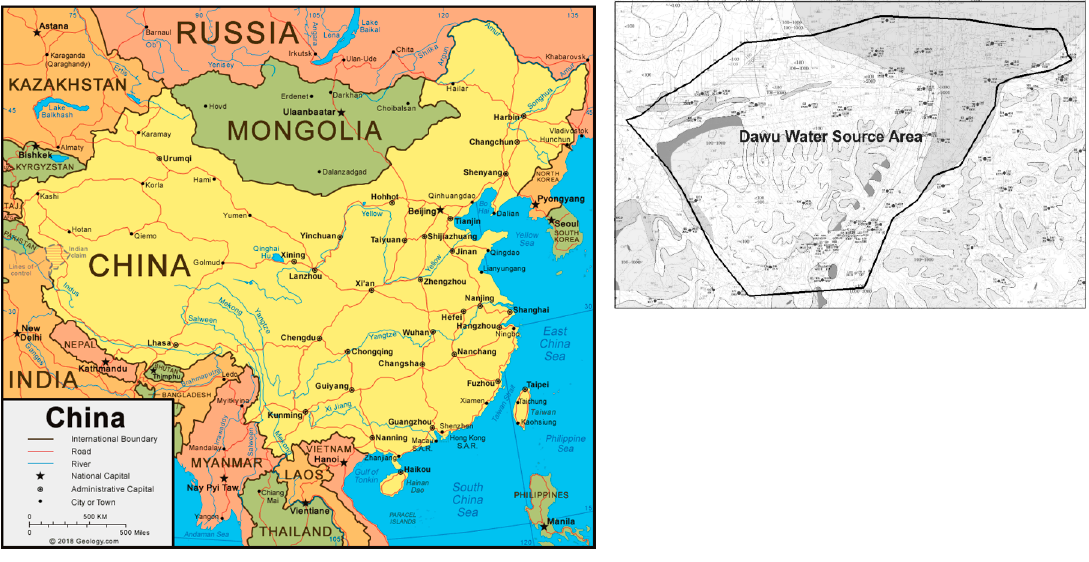
Figure 1. The location of the Dawu water source area.